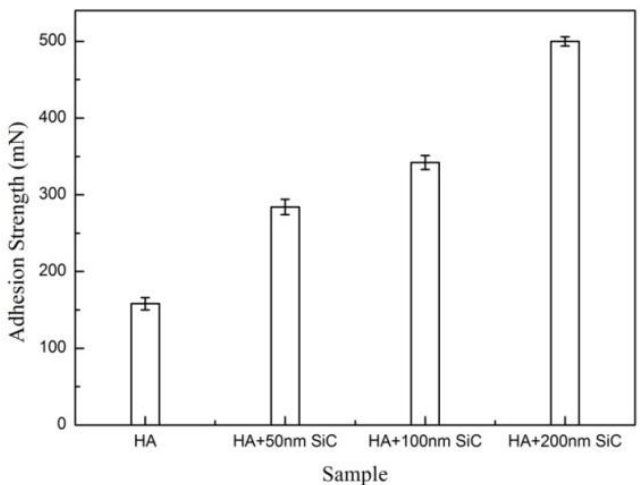
Figure 5. Adhesion strength of SiC-hydroxyapatite coatings at different SiC particle sizes.